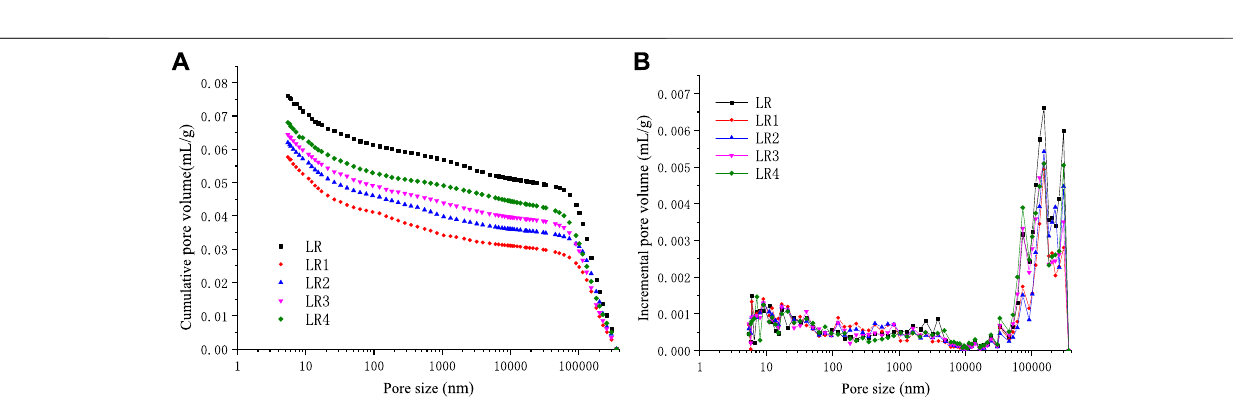
FIGURE6 | Pore volume vs pore sizeof Liulin mine soft coal after high-temperatureand high-pressure adsorption test. (A) Cumulative pore volume ofsoft coal (B) Incremental pore volume of soft coal.